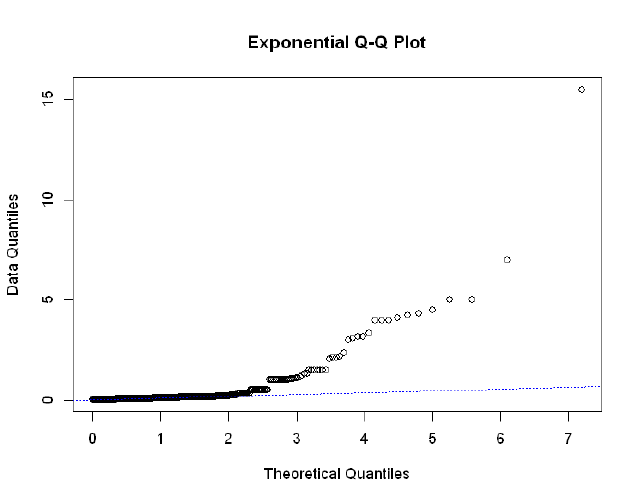
Figure 5. Exponential Q-Q plot of interarrival time between 2 occurring claims in Group